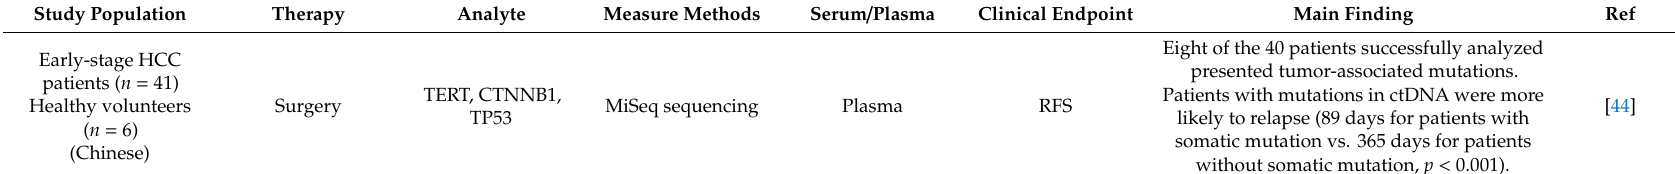
Table 2. Genetic profile of circulating tumor DNA (ctDNA) and therapy outcome in hepatocellular carcinoma (HCC)